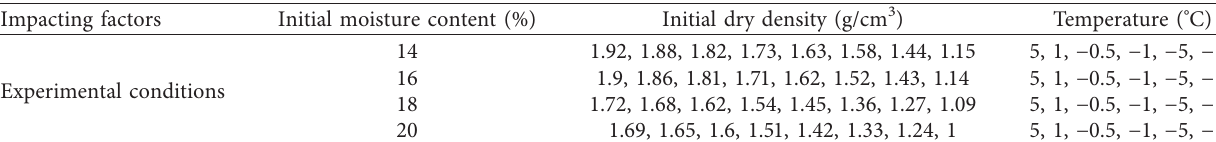
Table 2: Experimental conditions.